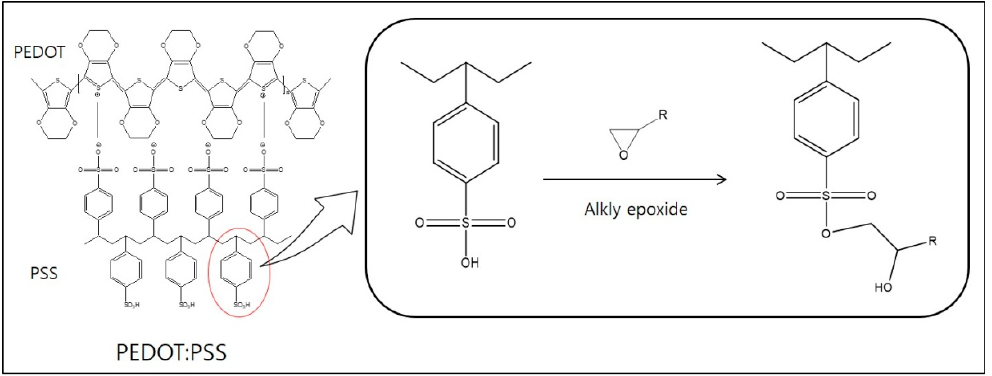
Figure 2. Suggested mechanism of the reaction of PEDOT:PSS with epoxyalkanes.